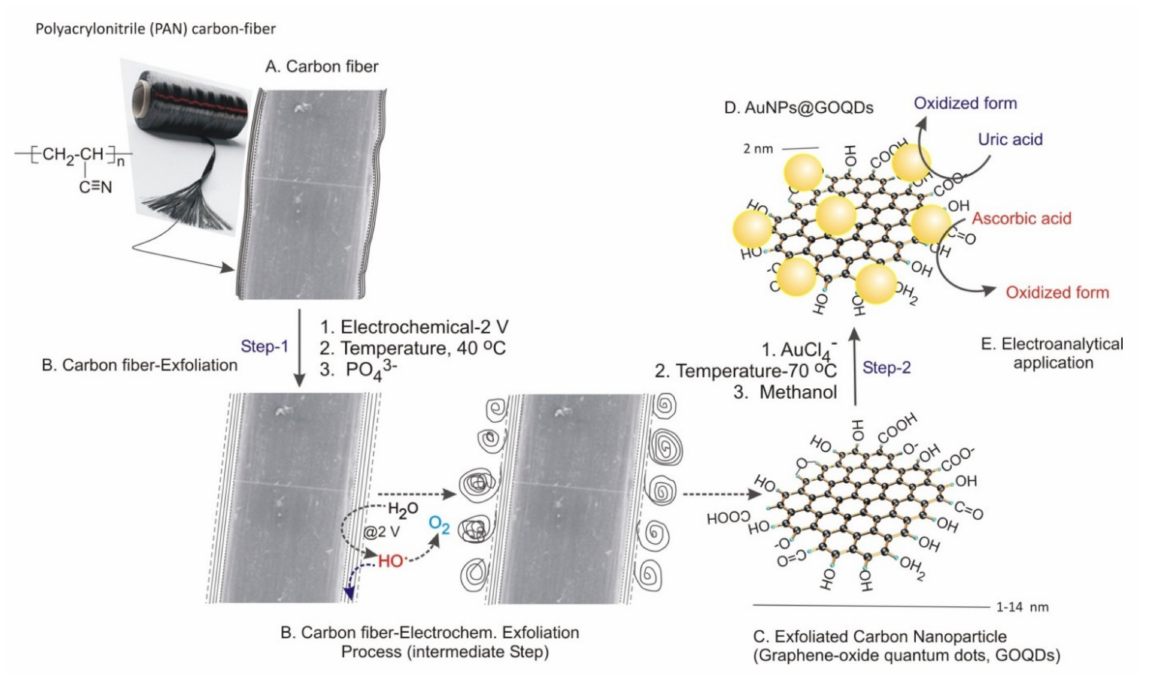
Scheme 1. Schematic representation of electrochemical exfoliation of carbon fiber into GOQDs (( A , B ), Step 1) and in situ gold-nanoparticle stabilized GOQDs (( C , D ), Step 2). ( E ) Electroanalytical application for simultaneous oxidation of uric acid (UA) and ascorbic acid